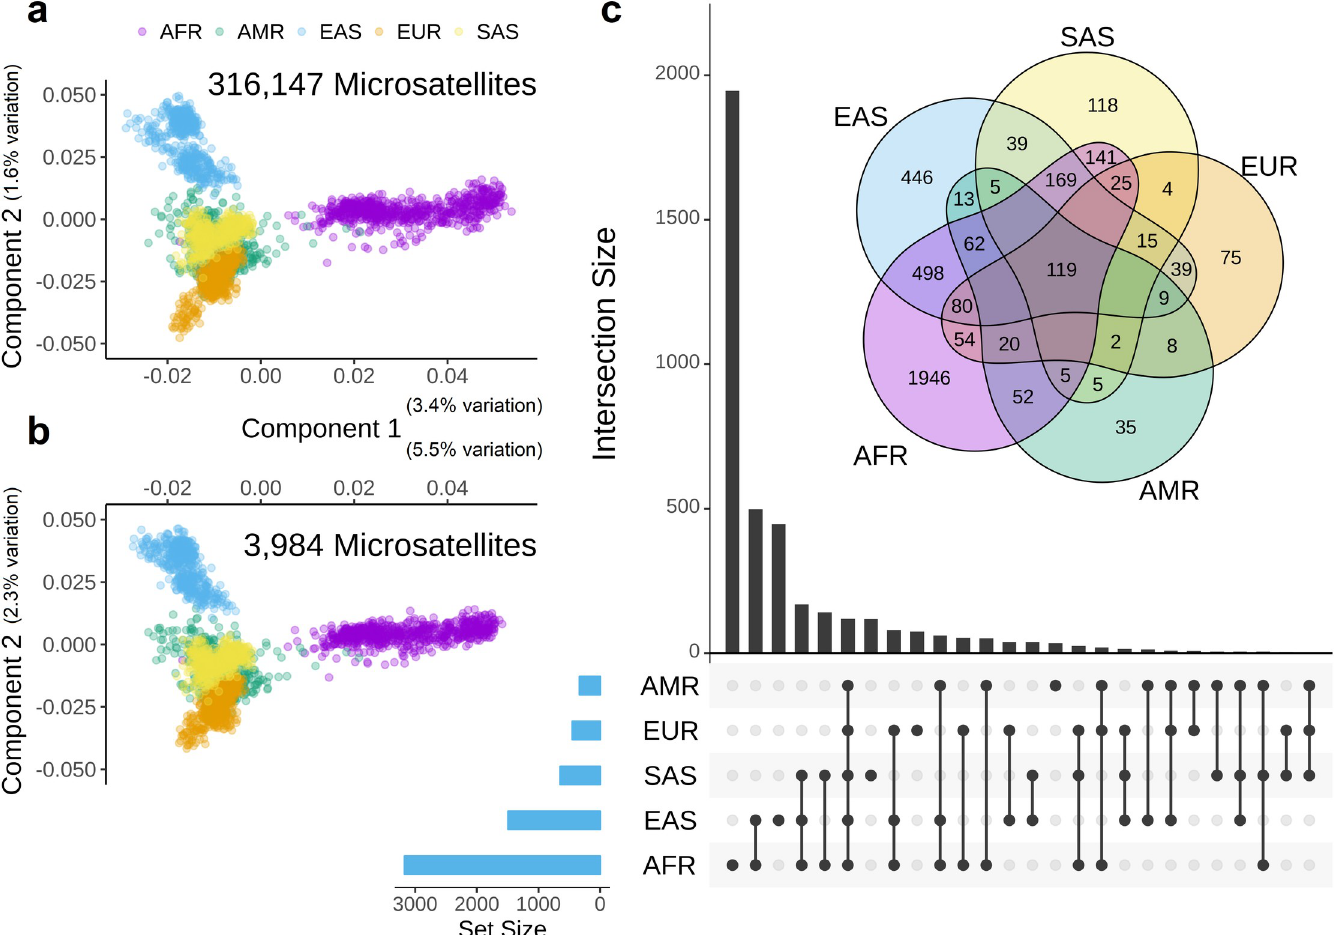
Fig 1. Discovery and analysis of EBML. a, Principal component analysis of 316,147 genome wide microsatellites reveals a distinct pattern of variation in 5 super- populations (ethnicities). b, Principal component analysis of 3,984 EBML reveals a pattern of variation similar to genome wide microsatellites. c, Number of EBML identified in five ethnicities: UpSet plot inset with 5-way Venn Diagram. Overlap indicates microsatellites specific to two or more ethnicities. Oval regions sum to 3,171 (AFR); 1,494 (EAS); 450 (EUR); 647 (SAS); and 335 (AMR). All regions sum to 3,984: the total number of EBML identified in this study. https://doi.org/10.1371/journal.pone.0225216.g001 PLOS ONE | https://doi.org/10.1371/journal.pone.0225216 December12,